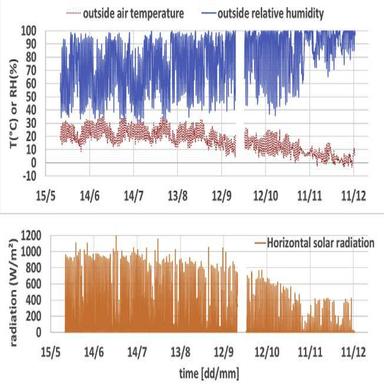
The outside temperature and relative humidity (top) and global horizontal solar radiation (bottom).